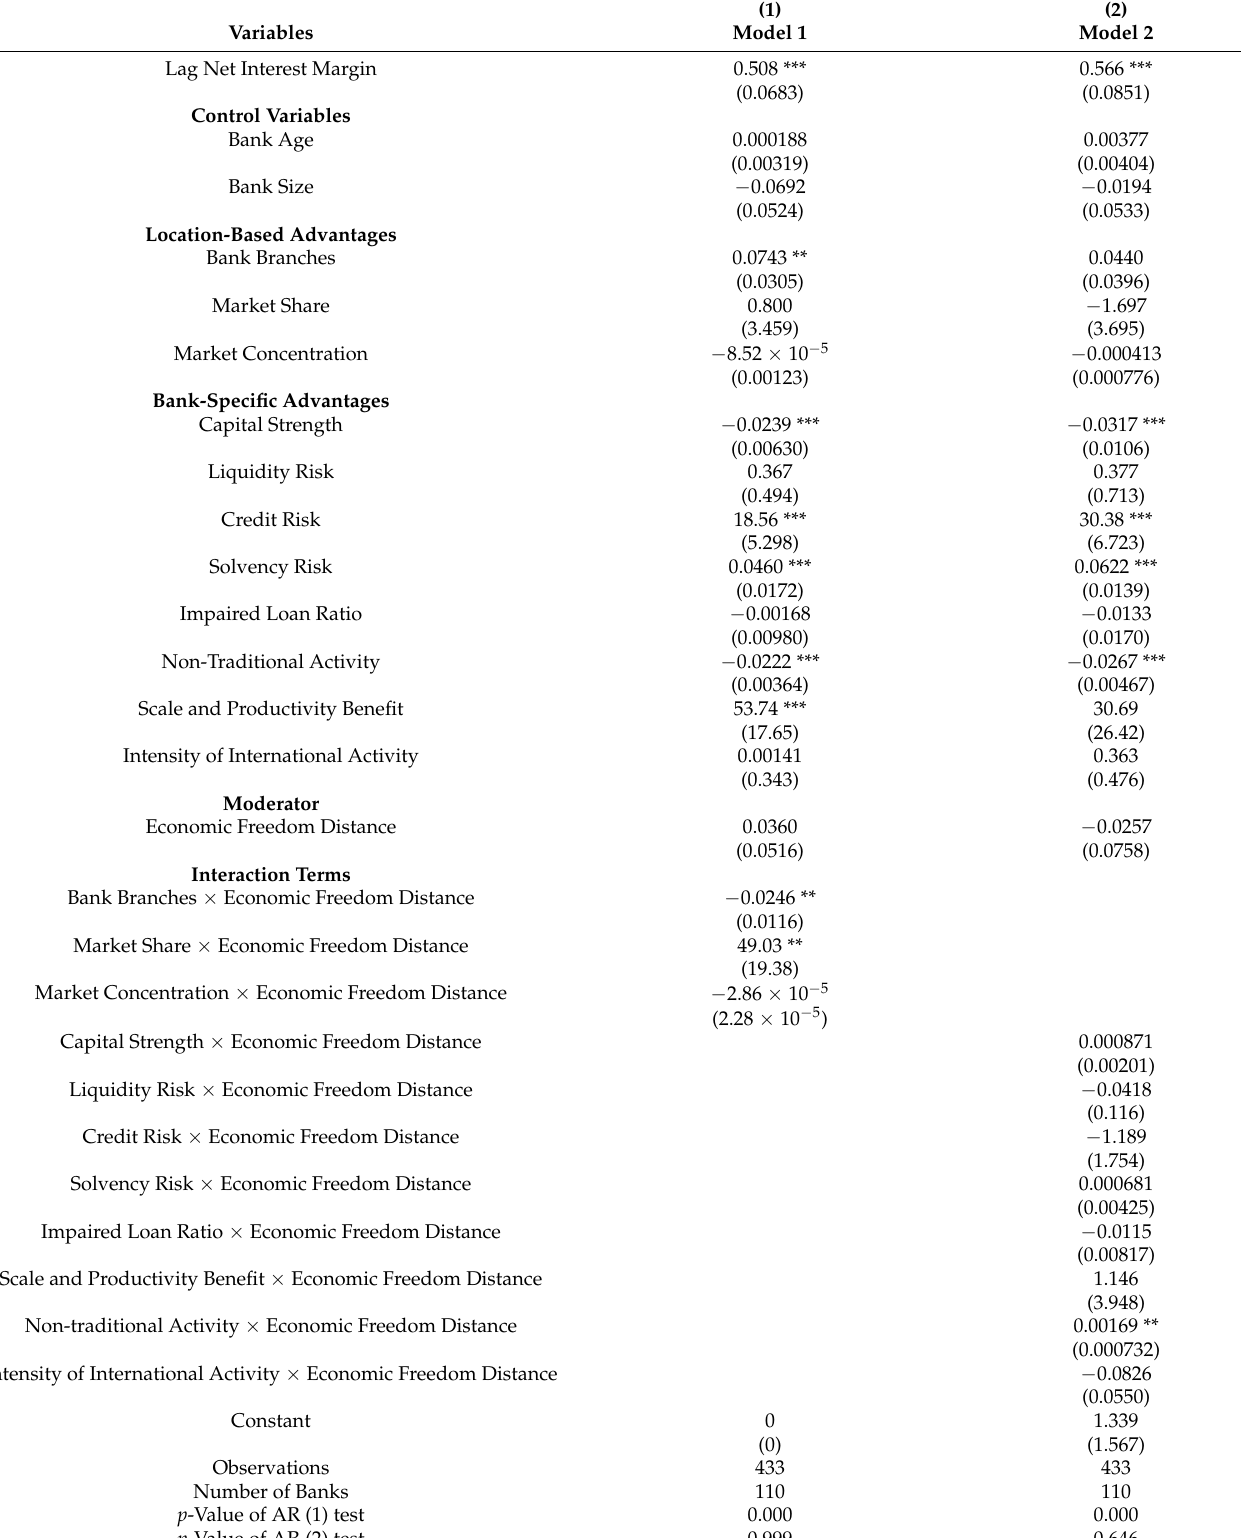
Table 8. Panel GMM model estimates